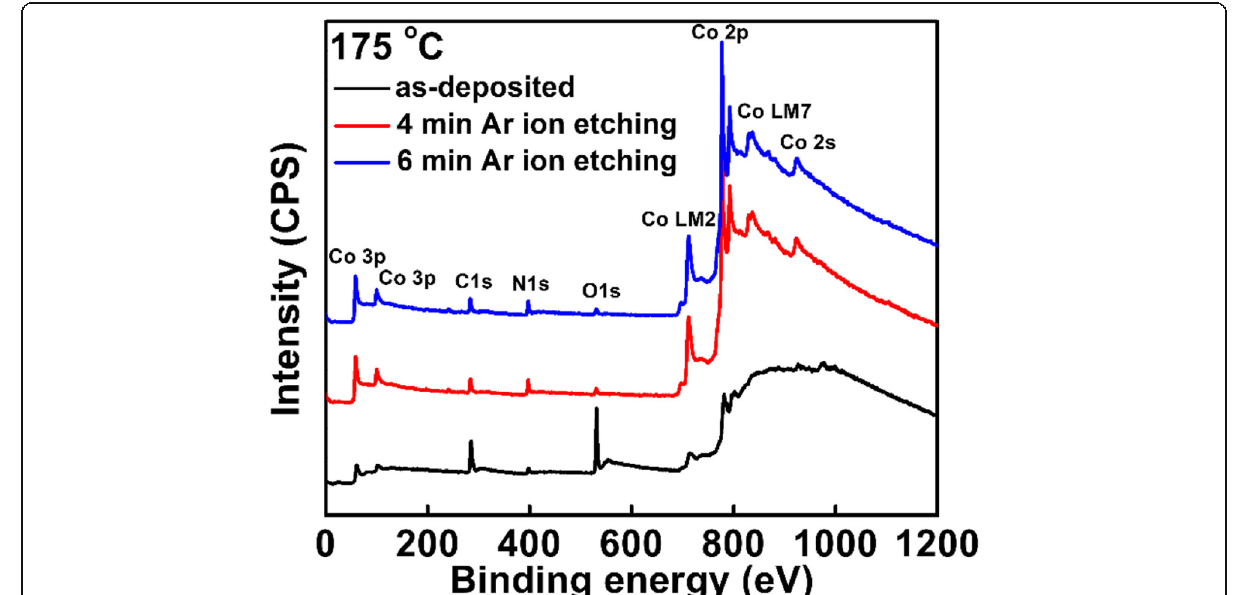
Fig. 2 The survey spectra of the Co films deposited at 100 °C with different etching